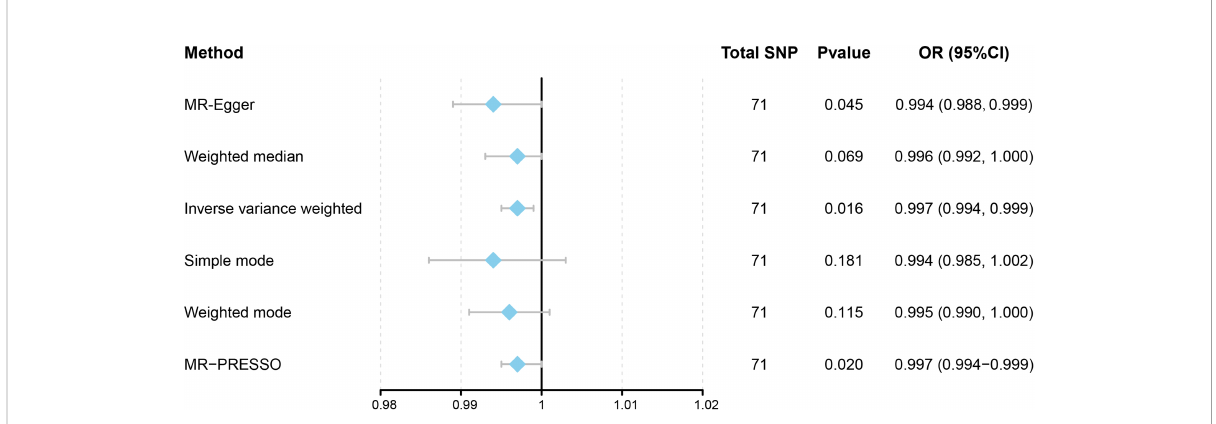
FIGURE 2 Forest plot to visualize causal effects of variation in Hypothyroidism on HCC. Presented odds ratios (OR) and con fi dence intervals (CI) correspond to the effects of Hypothyroidism on HCC. The results of Mendelian Randomization (MR) analyses using various analysis methods (MR-Egger, Weighted median, Inverse variance weighted, Simple mode, and Weighted mode) are presented for comparison. Total single- nucleotide polymorphism (SNP) indicates the number of genetic variants used as instruments for MR analysis.